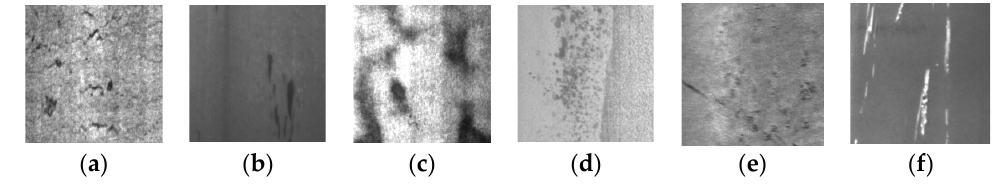
Figure 8. Surface defect sample of original strip. ( a ) Cr. ( b ) In. ( c ) Pa. ( d ) PS. ( e ) RS. ( f ) Sc.